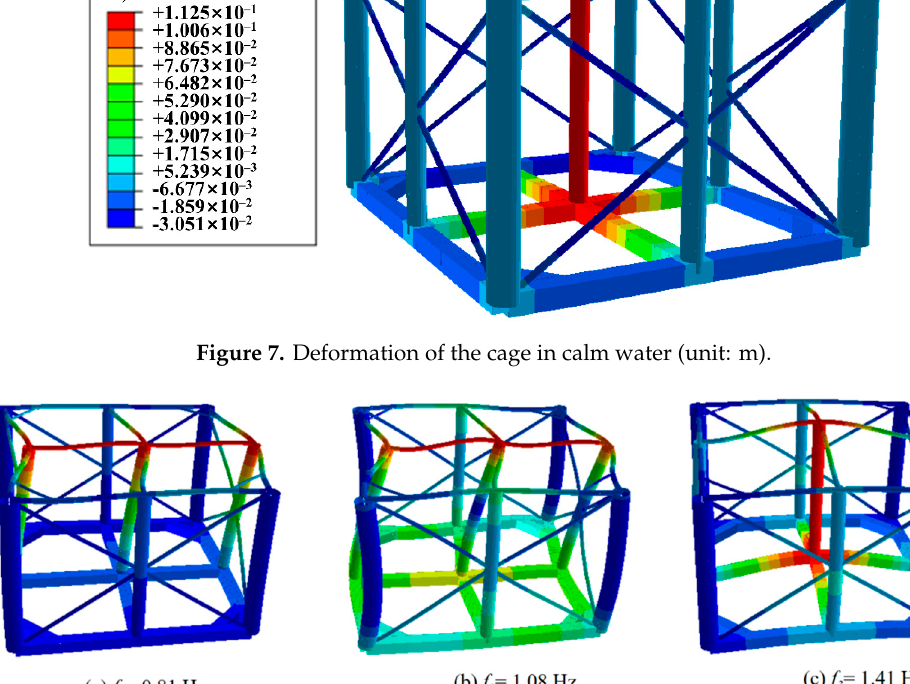
Figure 8. Natural modes and frequencies of the steel cage.